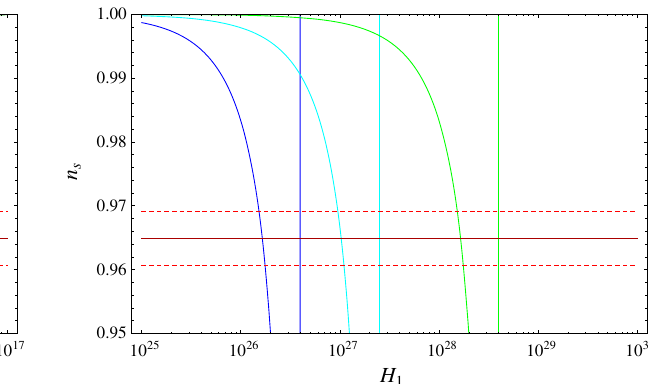
H 0 , respectively. The horizontal dark red line stands for n S = 0 . 9649, while the horizontal dashed red lines for the limits of its confidence interval, according to Planck 2018 results